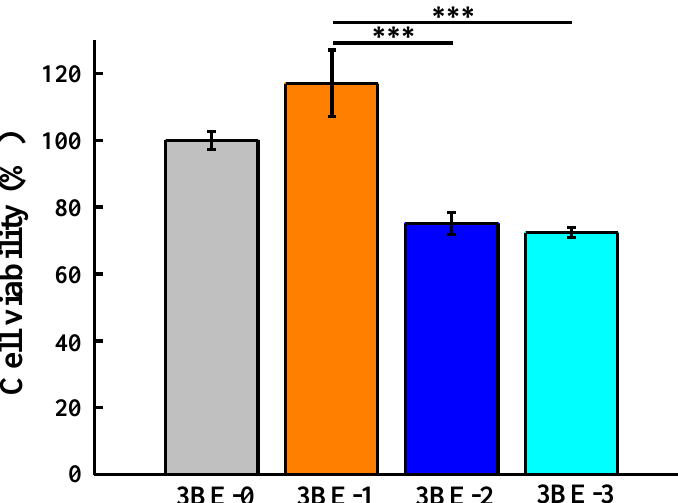
Figure 5. 3-(3,4-dimethylthiazol-2-yl)-2,5-diphenyltetrazoliium bromide (MTT) analysis for quanti- tative measurement of cell viability in different concentrations of the 3BE before bioprinting. The bar chart showed cell viability of L929 fibroblasts in each group was higher than 70%. The sample is considered an acute cytotoxic potential when viability value of the sample is reduced to < 70% of the blank according to ISO 109993-5. (*** p < 0.001).